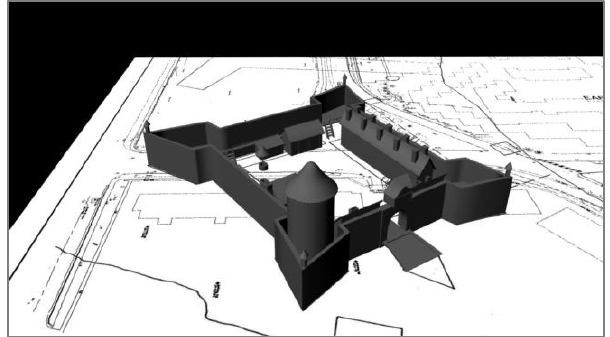
Figure 5: The wireframe model of the 1688 fortress.